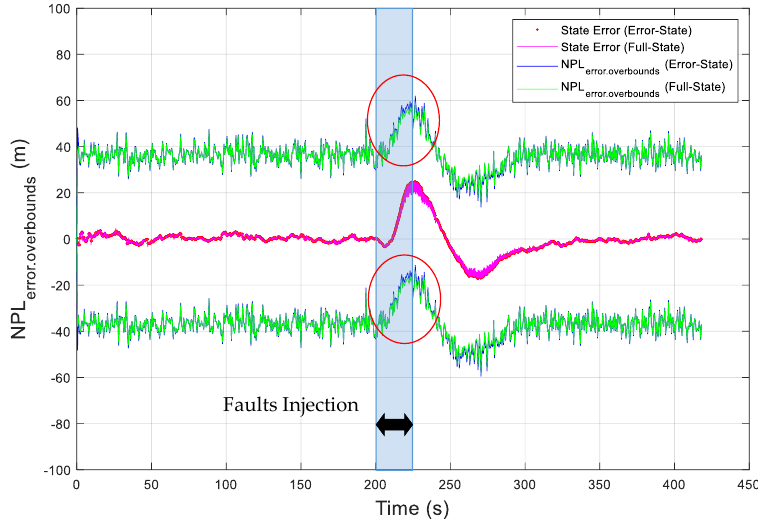
Figure 7. Simulation of the obtained error overboundings for the north position